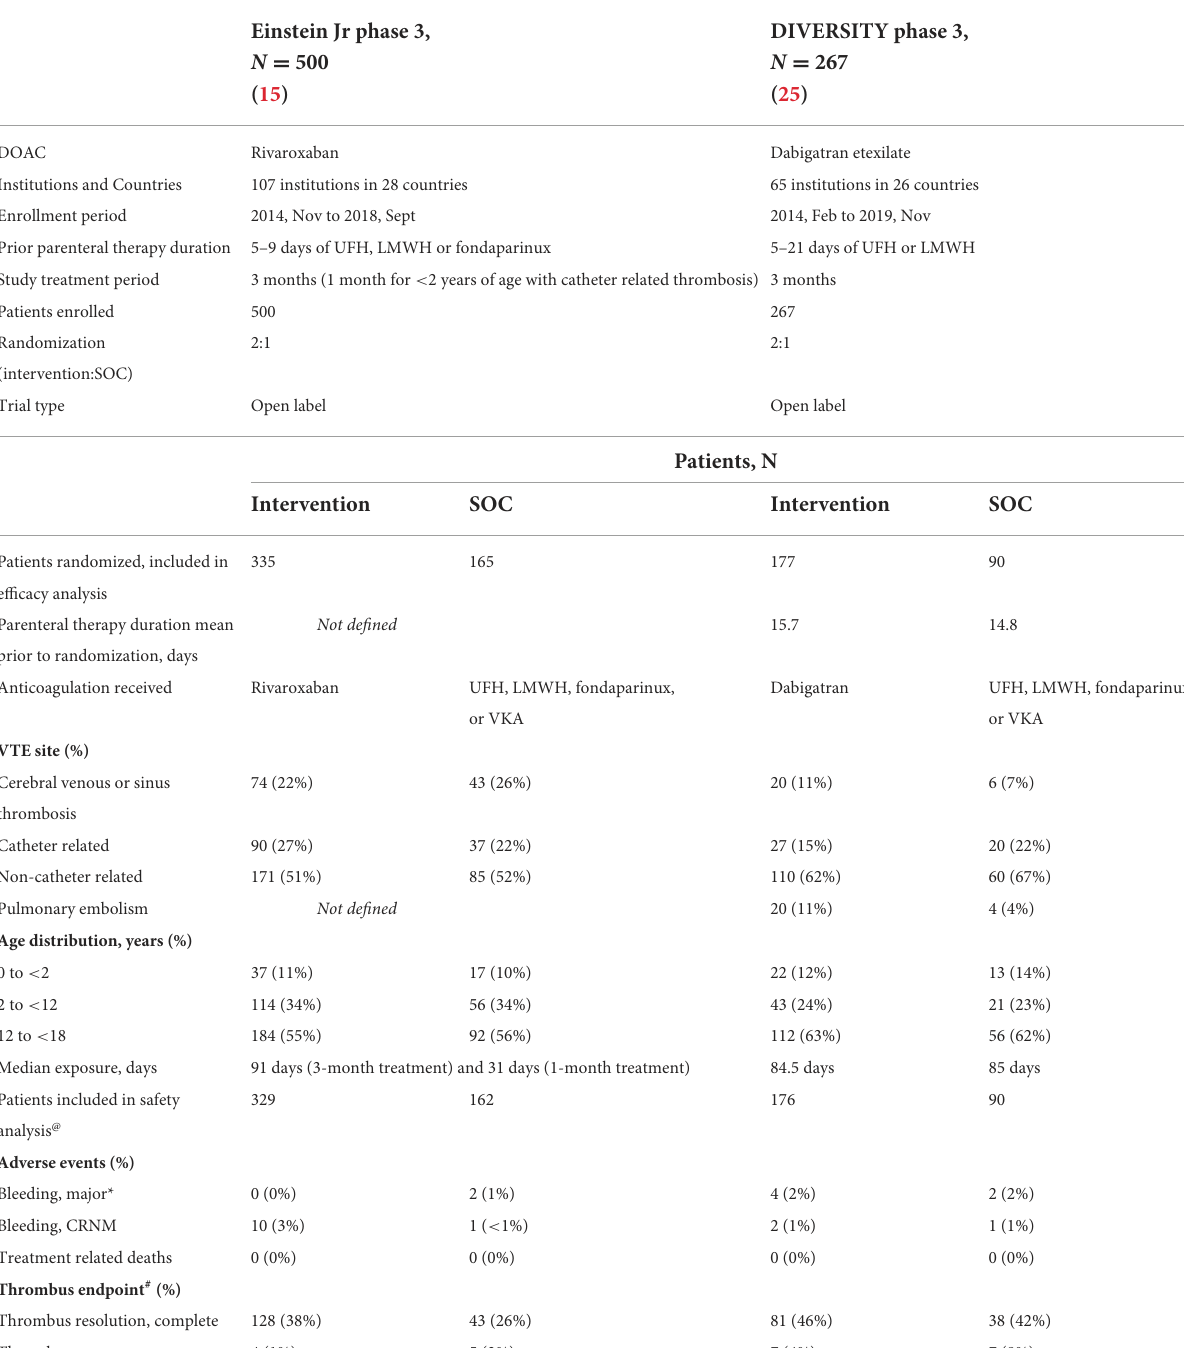
TABLE 4 Rivaroxaban and dabigatran etexilate trial